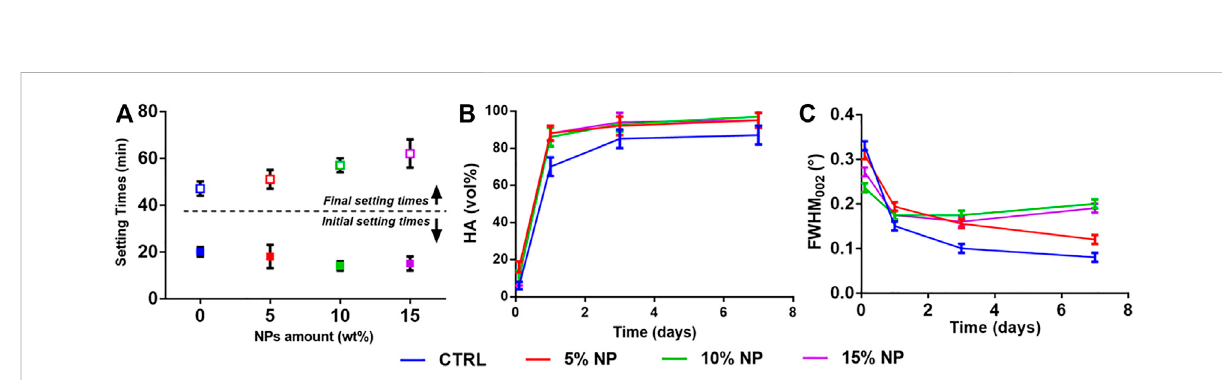
FIGURE 2 Effect of HA-NPs on SrCPC properties: (A) Initial and fi nal setting times; (B) Phase transformation into HA up to 7 days; (C) Full-Width at Half Maximum (FWHM) of the (002) peak up to 7